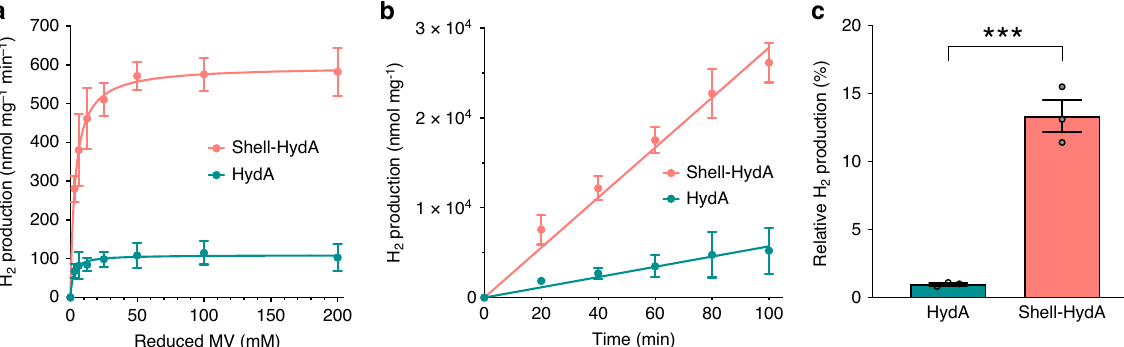
Fig. 4 In vitro Hydrogen production of the carboxysome shell-based nanoreactor. a Hydrogen production activity (nmol mg − 1 min − 1 ) of isolated free HydA and Shell-HydA at pH 8 as a function of different concentrations of MV + as the electron mediator reduced by sodium dithionite (DT), fi tted with Michaelis-Menten kinetics. Values represent mean ± s.d., n = 3 biologically independent experiments. b Kinetic hydrogen production of free HydA and Shell-HydA using 50 mM DT reduced MV + as the electron mediator at pH 8. Values represent mean ± s.d., n = 3 biologically independent experiments. c Relative activity of free HydA and Shell-HydA after oxygen exposure for 24 h at 4 °C, as a relative percentage of total activities measured under anaerobic conditions (see also Supplementary Fig. 10). Values represent mean ± s.d., n = 3 biologically independent experiments. *** p = 0.0009 (two-tailed unpaired t -test). Source data are provided as a Source data fi